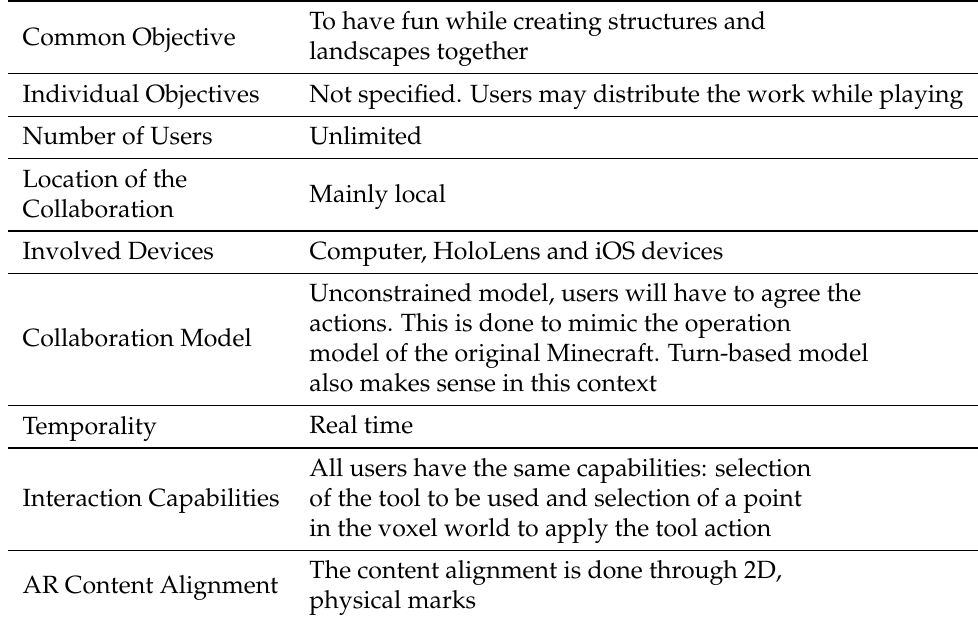
Table 2. Features of the voxel-world game